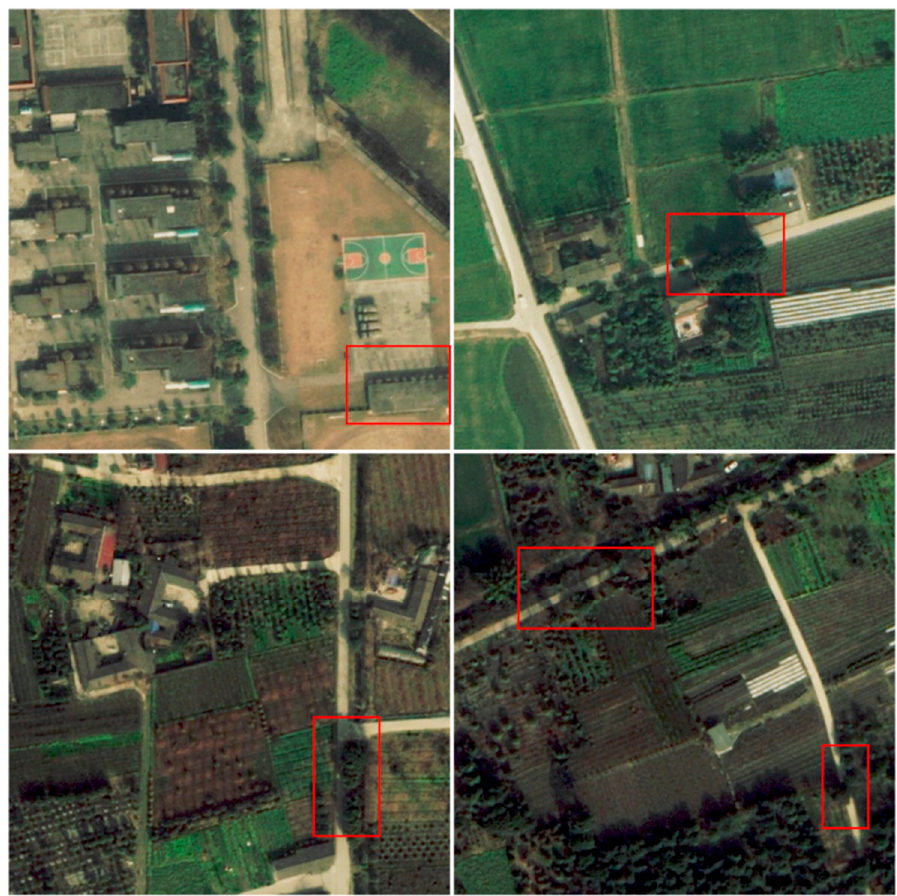
Figure 8. Figures of blocked roads.